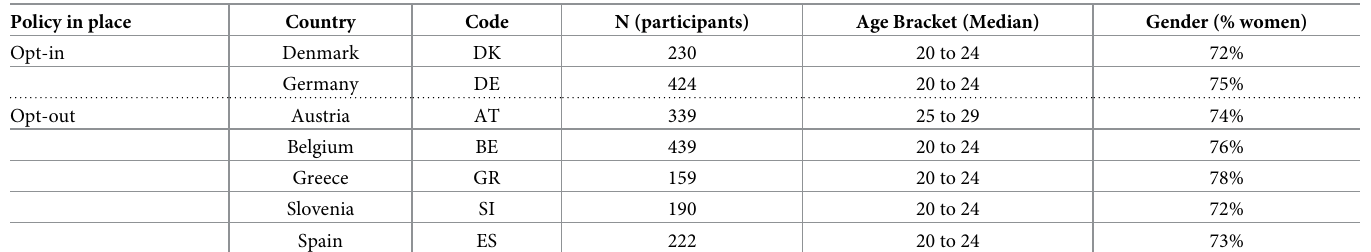
Table 1. Sample size, median age and gender distribution by country. Policy in place